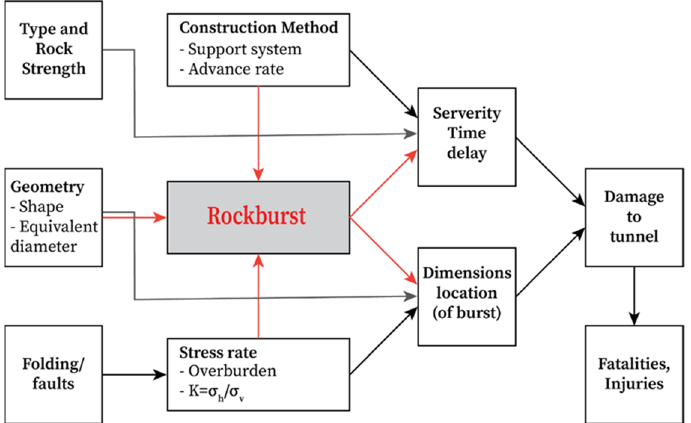
Figure 9. Influence diagram for rockbursts (modified from ref. [130]).